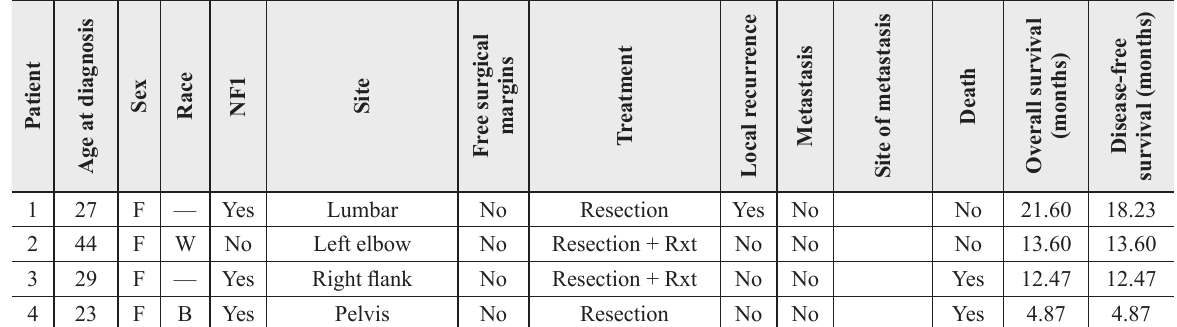
Clinical data of patients with malignant peripheral nerve sheath